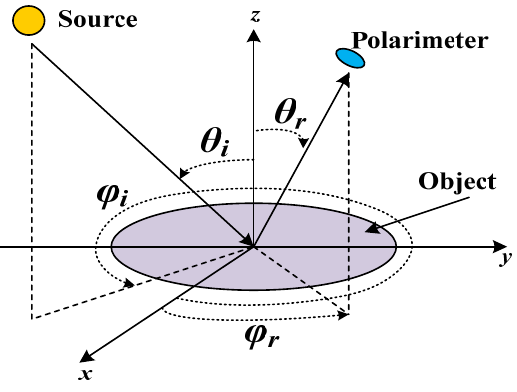
Figure 2. BRDF geometry [27].